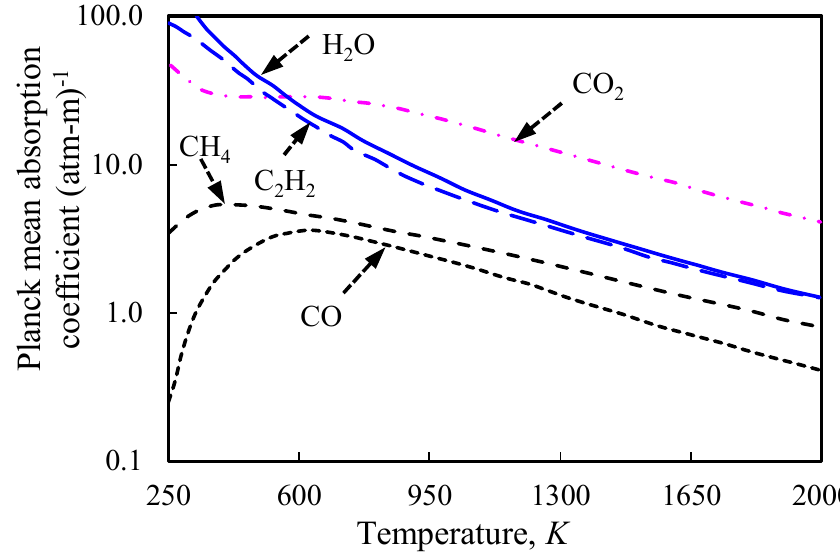
Figure 6. Planck mean absorption coefficient for various gases [25].